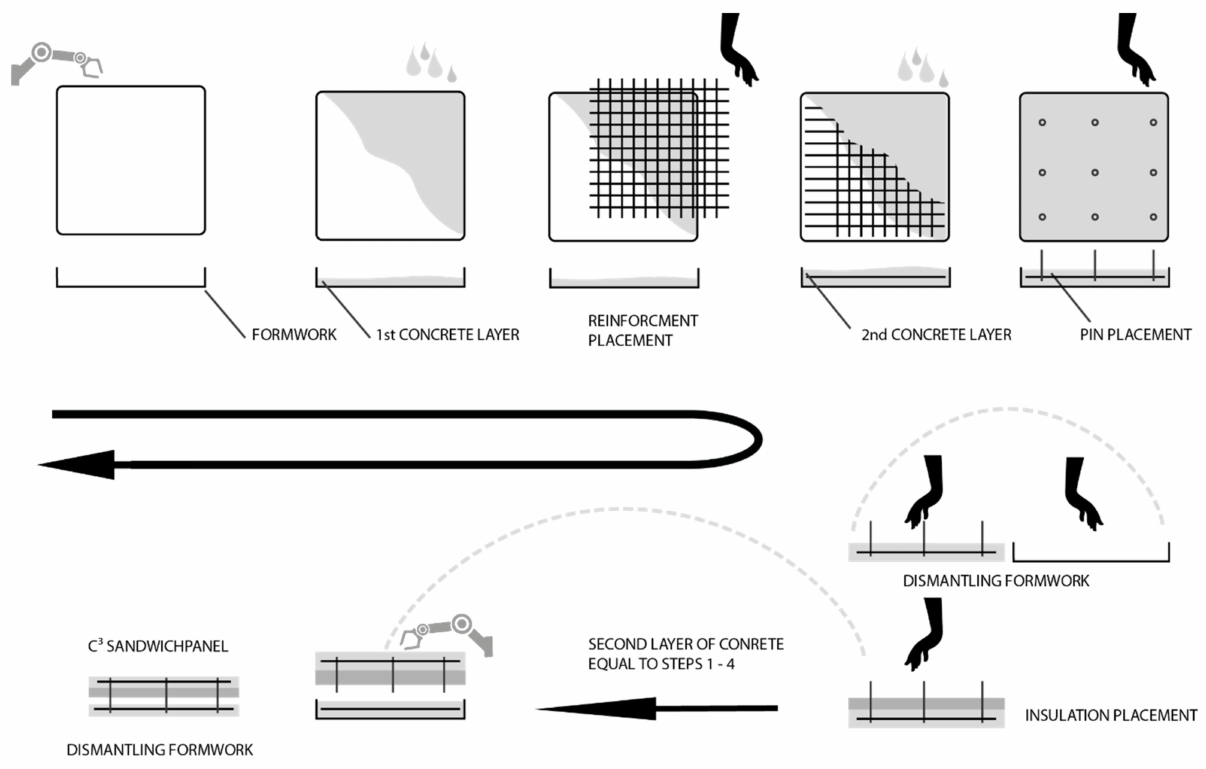
Figure 8. Schematic production of CRC sandwich